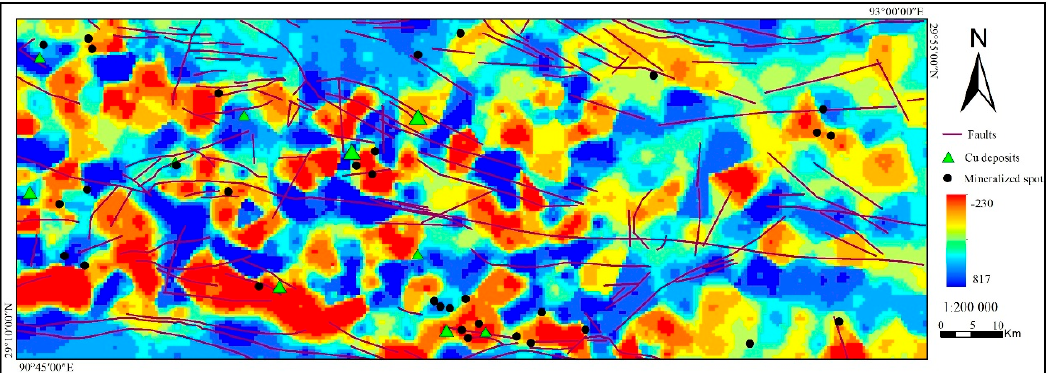
Figure 6. The regional aeromagnetic ∆ T by reduction to the pole based on the vertical first-order derivative map.